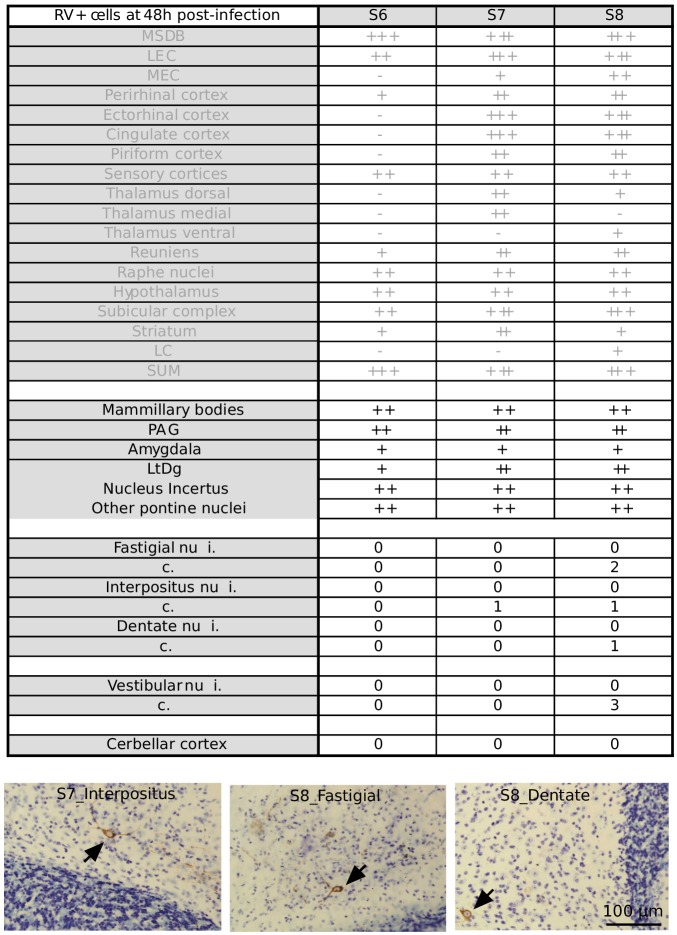
Summary table of RABV labeling across brain structures 48 hr after hippocampal rabies injection Overview of RABV labeling in different brain regions 48 hr post rabies injection in the hippocampus.The regions that were already stained at 30H post-infection are represented in gray. In two mice, few rabies-positive cells were detected in the deep cerebellar and vestibular nuclei. (-) denotes no labeling, (+/-) few cells, (+) minor labeling, (++) fair labeling, (+++) strong labeling. For the deep cerebellar and vestibular nuclei, ipsi (i.) and contralateral (c.) sides are distinguished. Sensory cortices include somatosensory, auditory and visual cortices. MSDB, medial septum/diagonal band of Broca; LEC, lateral entorhinal cortex; MEC, medial entorhinal cortex; LC, locus coeruleus; SUM, supramammillary nucleus; PAG, periaqueductal gray; LtDg, laterodorsal tegmental nucleus.